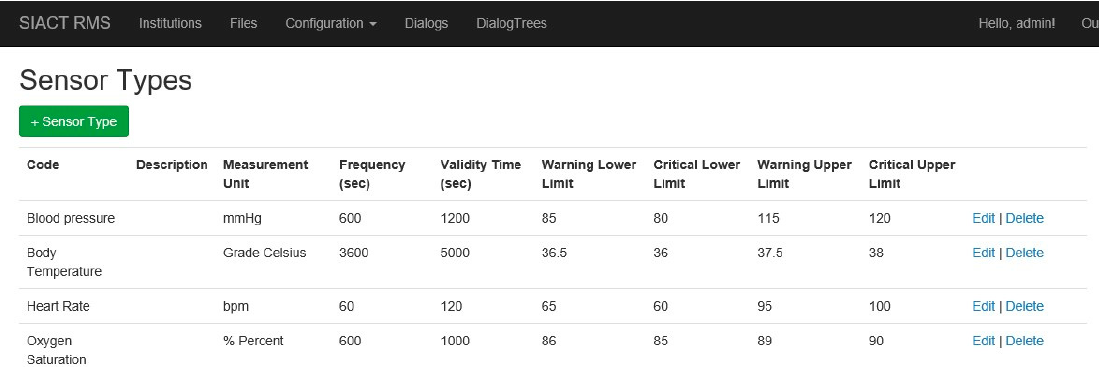
Figure 15. Building of a tree with several hierarchical levels in the Patient WEB Application.